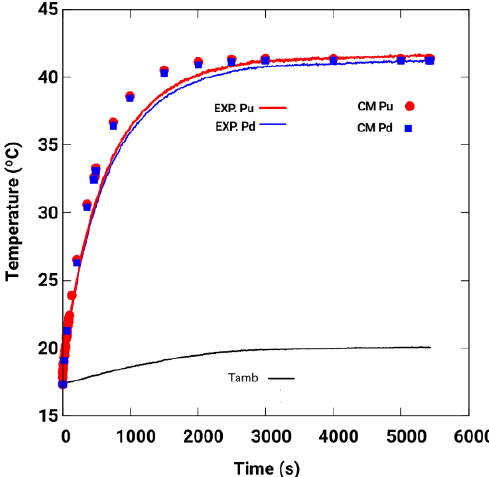
Figure 19. CM perimeter simulations with adjustment parameters h eff (Cu) = 8.2, h eff (Fe) = 27.4 W/m 2 K in Pu and Pd, and experimental data Exp. Pu and Exp. Pc, for w r = 15.28 rad/s.